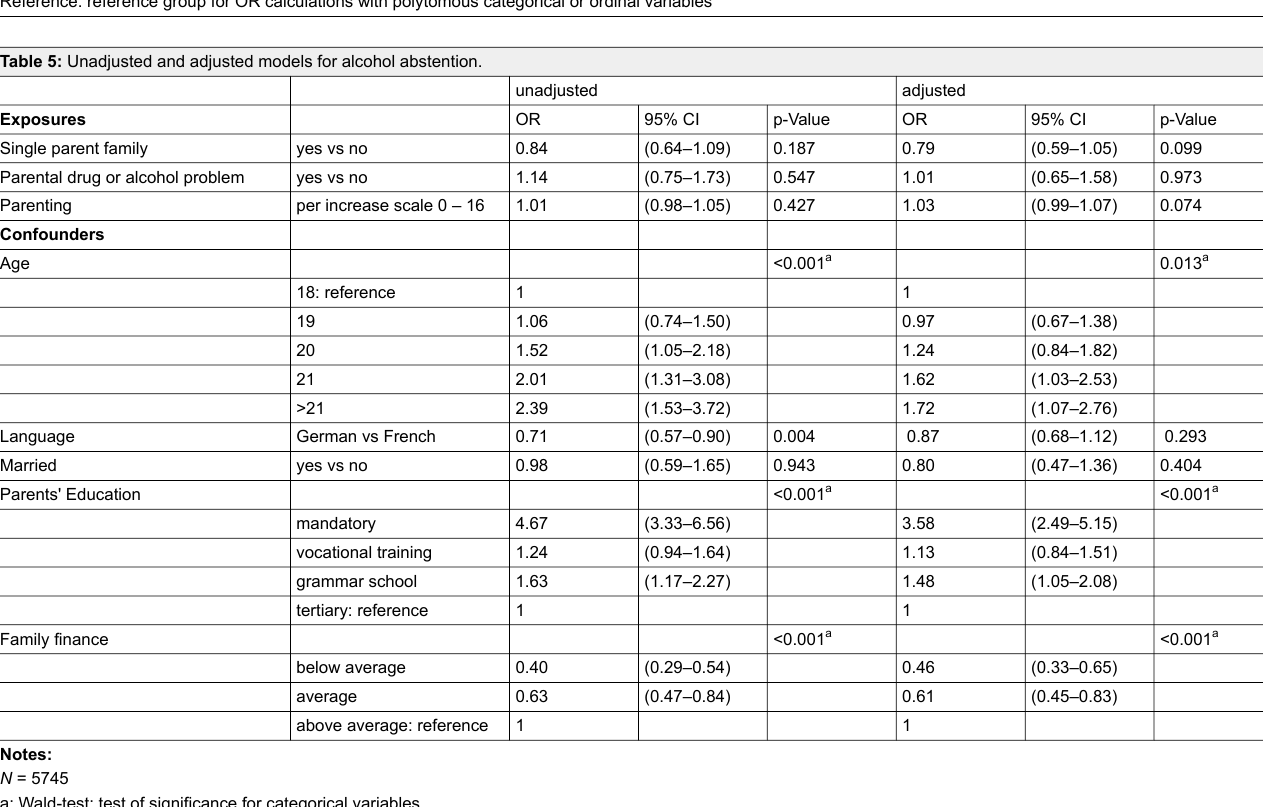
Table 5: Unadjusted and adjusted models for alcohol